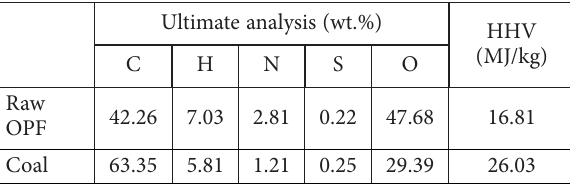
Table 1. Properties of raw OPF and